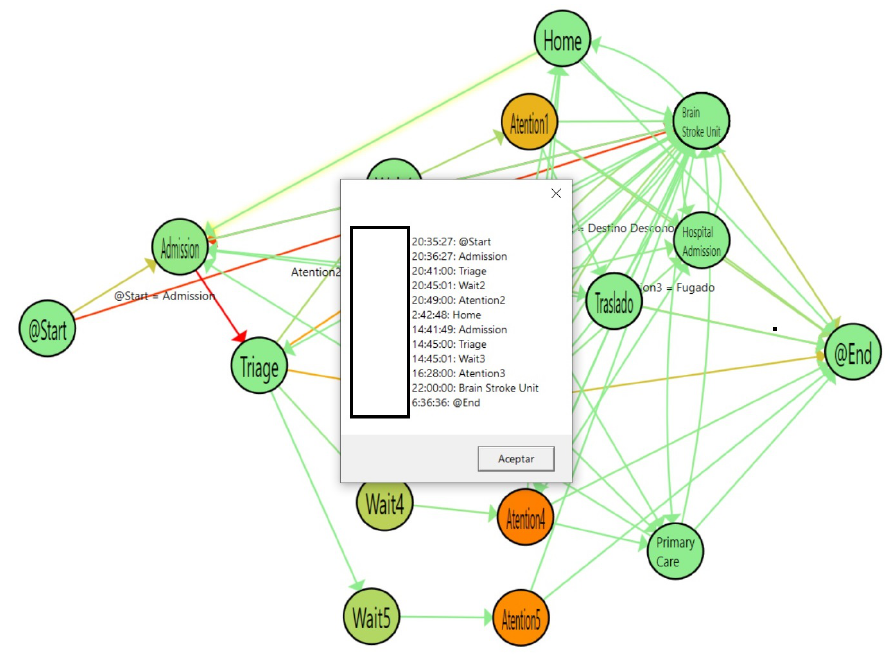
Figure 17. Individual flow for Readmitted